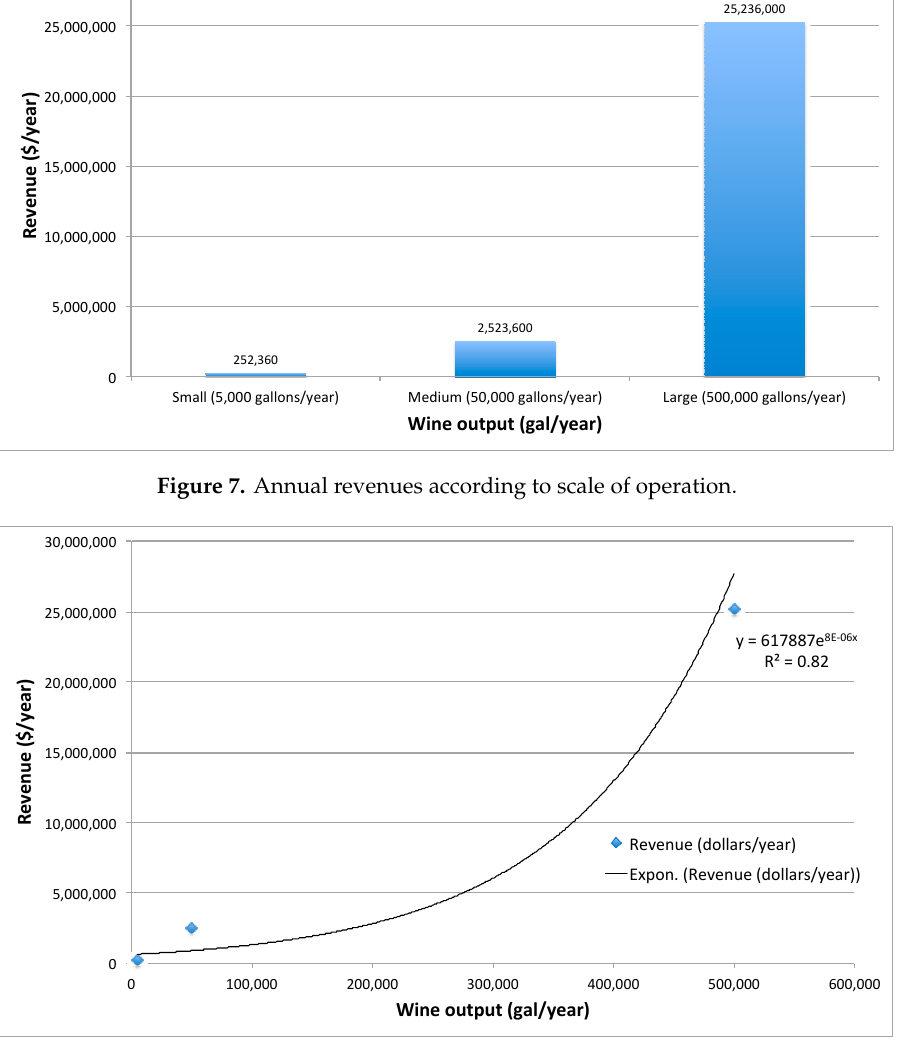
Figure 8. Annual revenues according to scale of operation (showing exponential trendline).